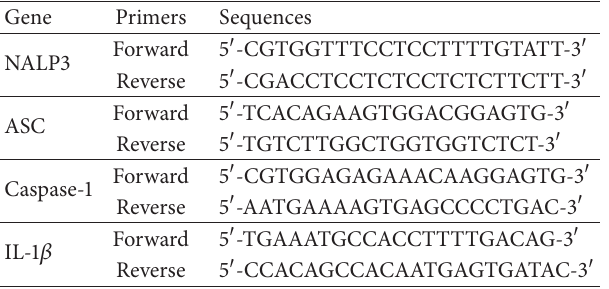
Table 1: Summary of the RT-PCR primers